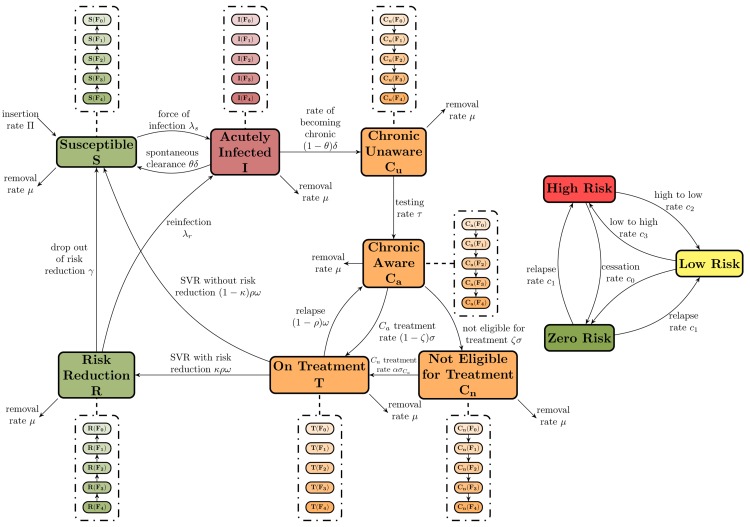
HCV Transmission and Disease Progression Model Schematic.